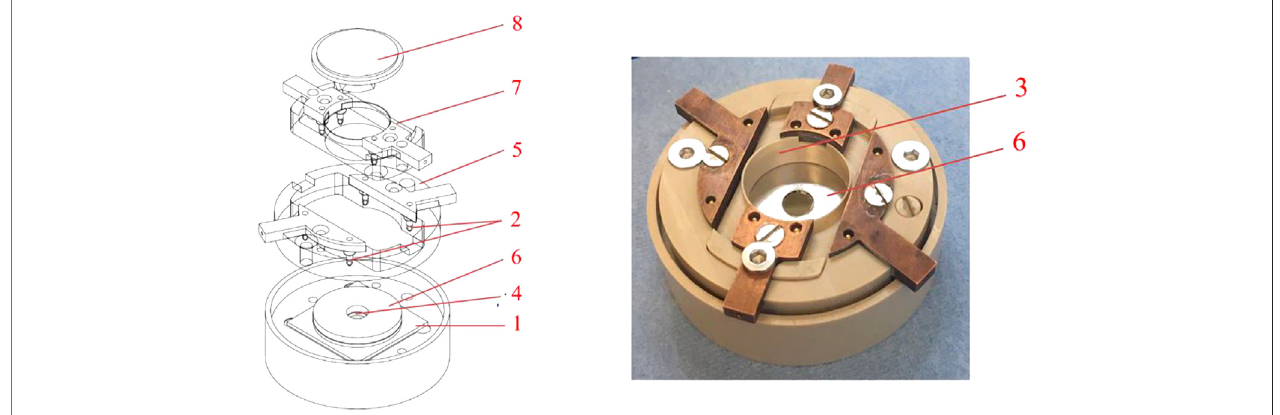
FIGURE3| Left: Dimensions and FEM analyses ofthe CDT-NCHR Diamondcoated probe Right: Simulation results offrequencyshiftasafunctionofadded mass and frequency shift as a function of diameter of a lithium sphere situated at the end of the tip.